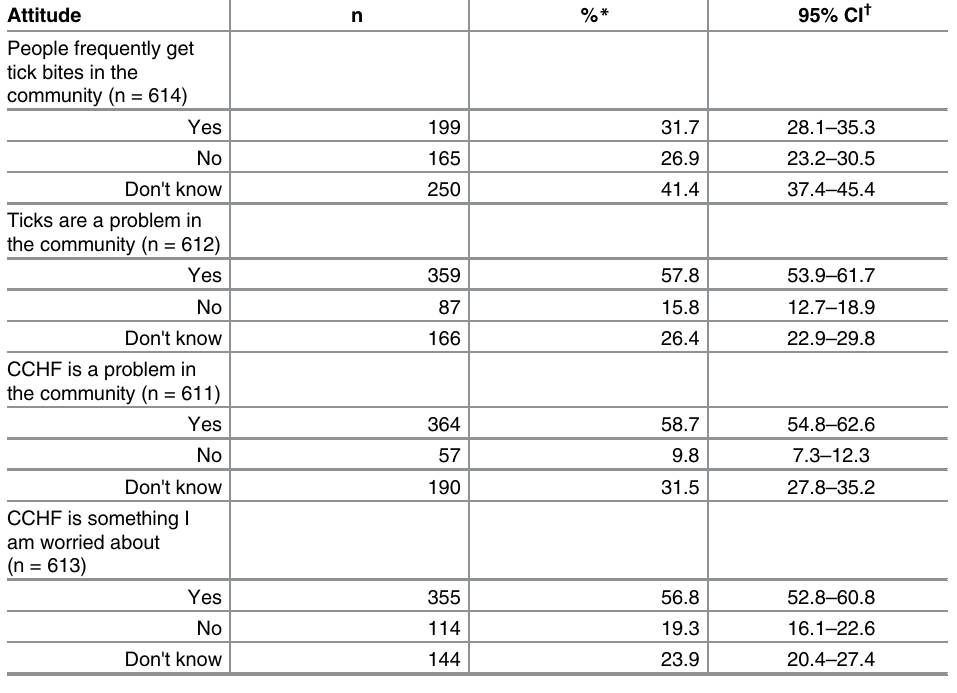
Table 3. Attitudes regarding Crimean-Congo hemorrhagic fever (CCHF) and ticks among survey par- ticipants during an investigation of the 12 rural villages reporting at least one 2014 CCHF case from January to September 2014 in Georgia. Attitude n % * People frequently get tick bites in